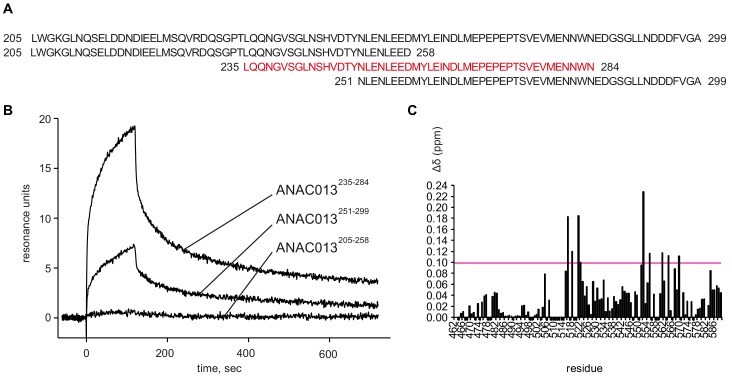
Analysis of interaction of the ANAC013-derived peptides with the RST domain of RCD1.(A) According to yeast two-hybrid data (O'Shea et al., 2017), ANAC013 residues 205–299 are responsible for interaction with RCD1. To narrow down the RCD1-interacting domain, three overlapping peptides ANAC013205-258, ANAC013235-284, ANAC013251-299 were designed and tested for their binding to RCD1 by surface plasmon resonance. (B) Surface plasmon resonance interaction analysis of three ANAC013-derived peptides with the C-terminal domain of RCD1. The strongest binding was detected for ANAC013 peptide 235–284 (red in panel A), which was further used for the NMR titration experiment with the purified C-terminal domain of RCD1 (RCD1468-589). (C) Histogram depicting the changes in 1H and 15N chemical shifts in RCD1468-589 upon addition of the ANAC013235-284 peptide. Changes were quantified according to the ‘minimum chemical shift procedure’. That is, each peak in the free form spectrum was linked to the nearest peak in the bound form spectrum. An arbitrary value −0.005 ppm was assigned to residues for which no data could be retrieved. The largest changes (Δδ ≥ 0.10 ppm) were found for residues located on one face of the domain, formed by the first and last helices and loops between the first and the second, and the third and the fourth helices. These residues probably representing the peptide interaction site are highlighted on the RSTRCD1 structure in Figure 7A
inset. In addition, relatively large perturbations were observed throughout the RST domain, and notably, in the unstructured C-terminal tail, which might originate from a conformational rearrangement in the domain induced by ligand binding.